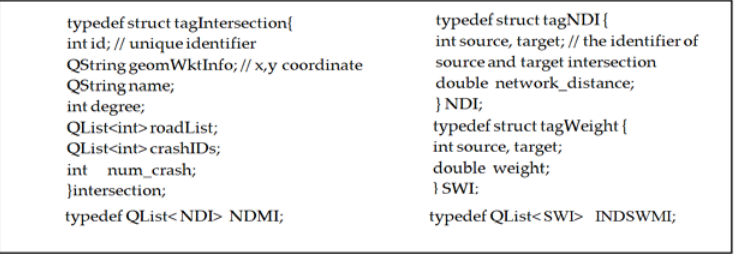
Figure 2. Definition of main data types of the INDSWMI generation algorithm.